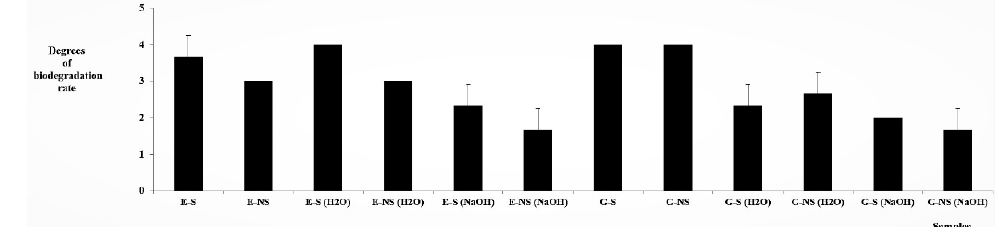
Figure 3. The samples covered by molds after finishing of the test (from left to right) according to degrees in [44]: E = epoxy sample, E-(H 2 O) = epoxy-straw-H 2 O sample, E-(NaOH) = epoxy-NaOH sample, G-glue sample, G-(H 2 O) = glue-H 2 O sample, G-(NaOH) = glue-NaOH sample. “S” = sterile sample, “NS” = nonsterile